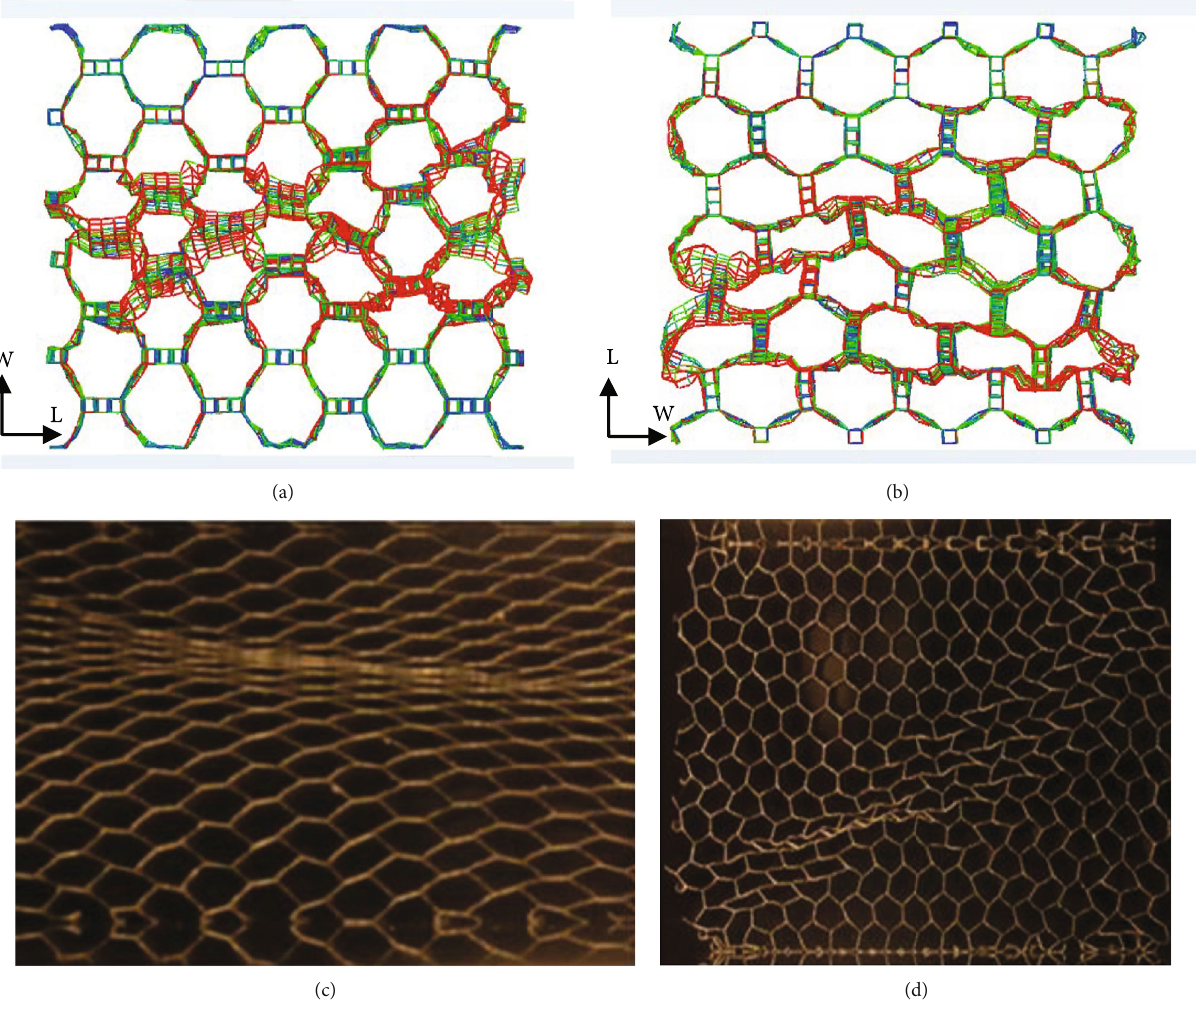
Figure 15: Simulation and experimental comparison of coplanar compression deformation of a square honeycomb. (a) W direction deformation of simulated honeycomb. (b) L direction deformation of simulated honeycomb. (c) Deformation in the W direction of the experimental honeycomb. (d) Deformation in the L direction of the experimental